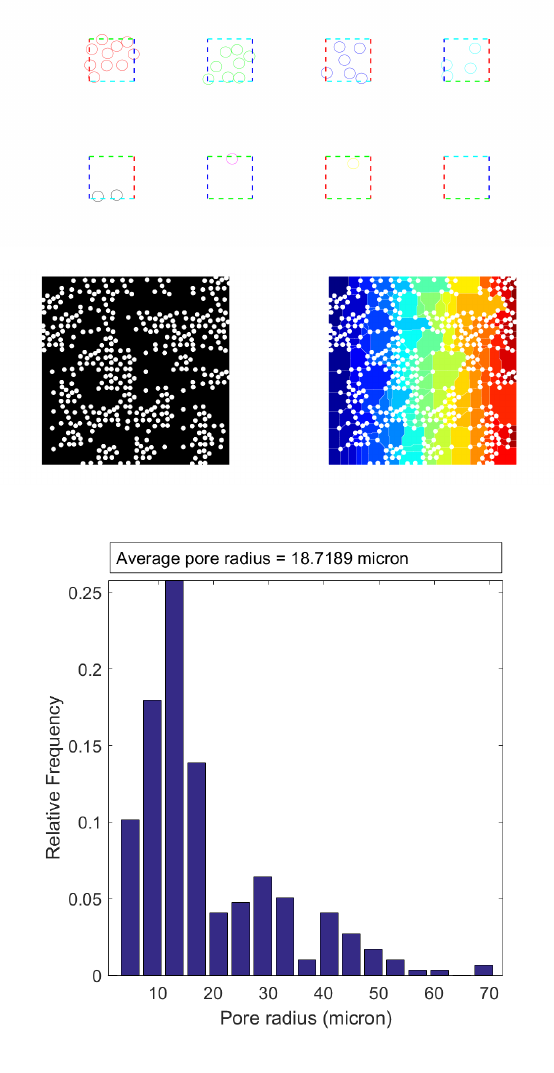
Figure 7. Artifitial tiling 10 × 10 from basic set in- cluding 10, 8, 6, 4, 2, 1, 1, 0 equal-sized discs.